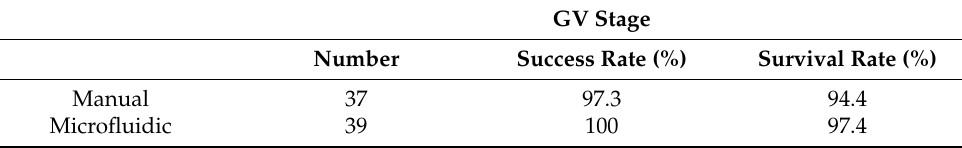
Table 1. Experimental results of mouse GV stage oocytes